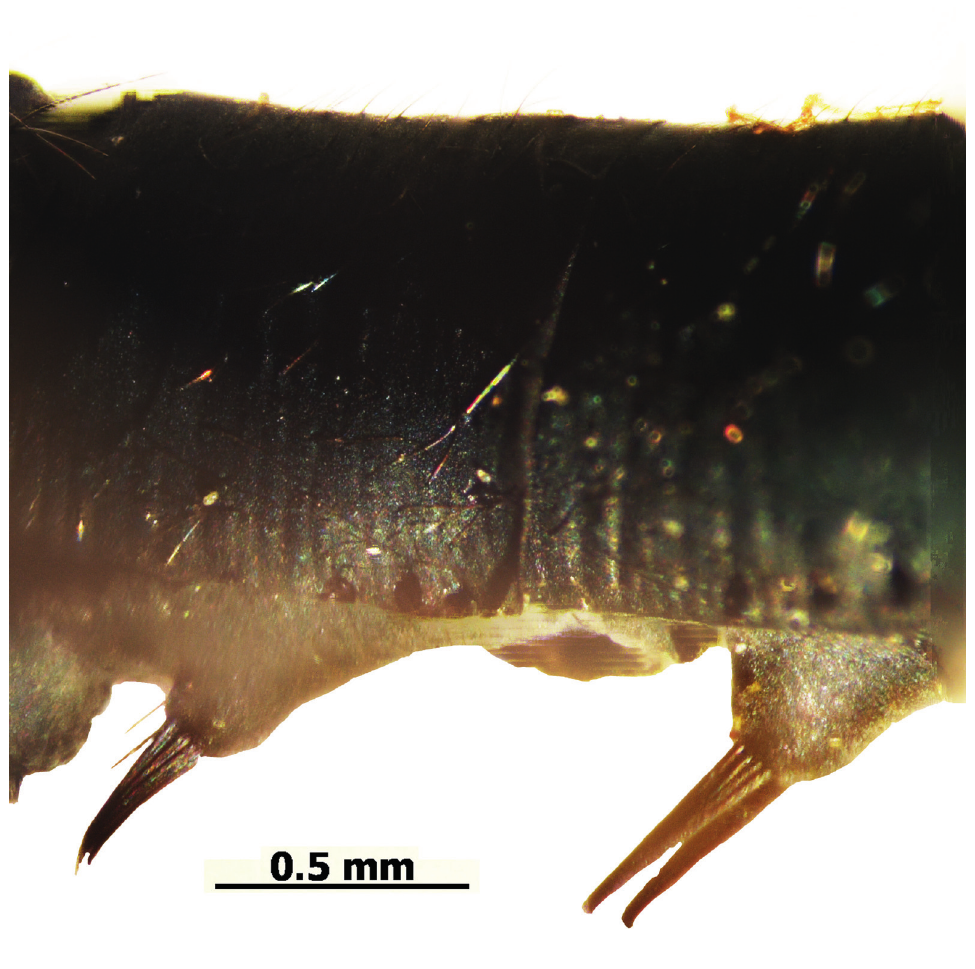
Fig. 2. Diostracus ( Sphyrotarsus ) kustovi sp. nov. Male holotype. Abdominal segments 2 and